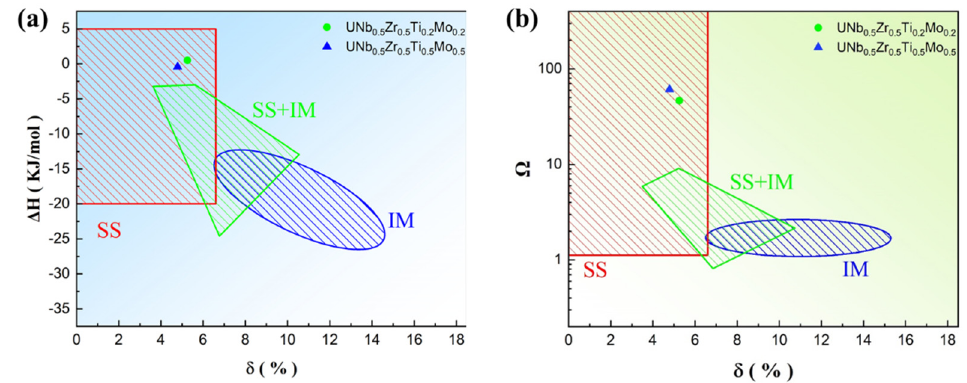
9 of 13 The thermodynamic properties of Nb-Zr-U-Ti-Mo HEAs are shown in Table 8. The planned UNb 0.5 Zr 0.5 Ti x Mo x HEAs were all solid solution phases, as evidenced by the rela- tionship between δ - Δ H and δ - Ω in Figure 9. Based on its VEC, we can predict that the developed alloy will be a BCC phase. Table 8. Thermodynamic parameters of U-Nb-Zr-Ti-Mo HEAs